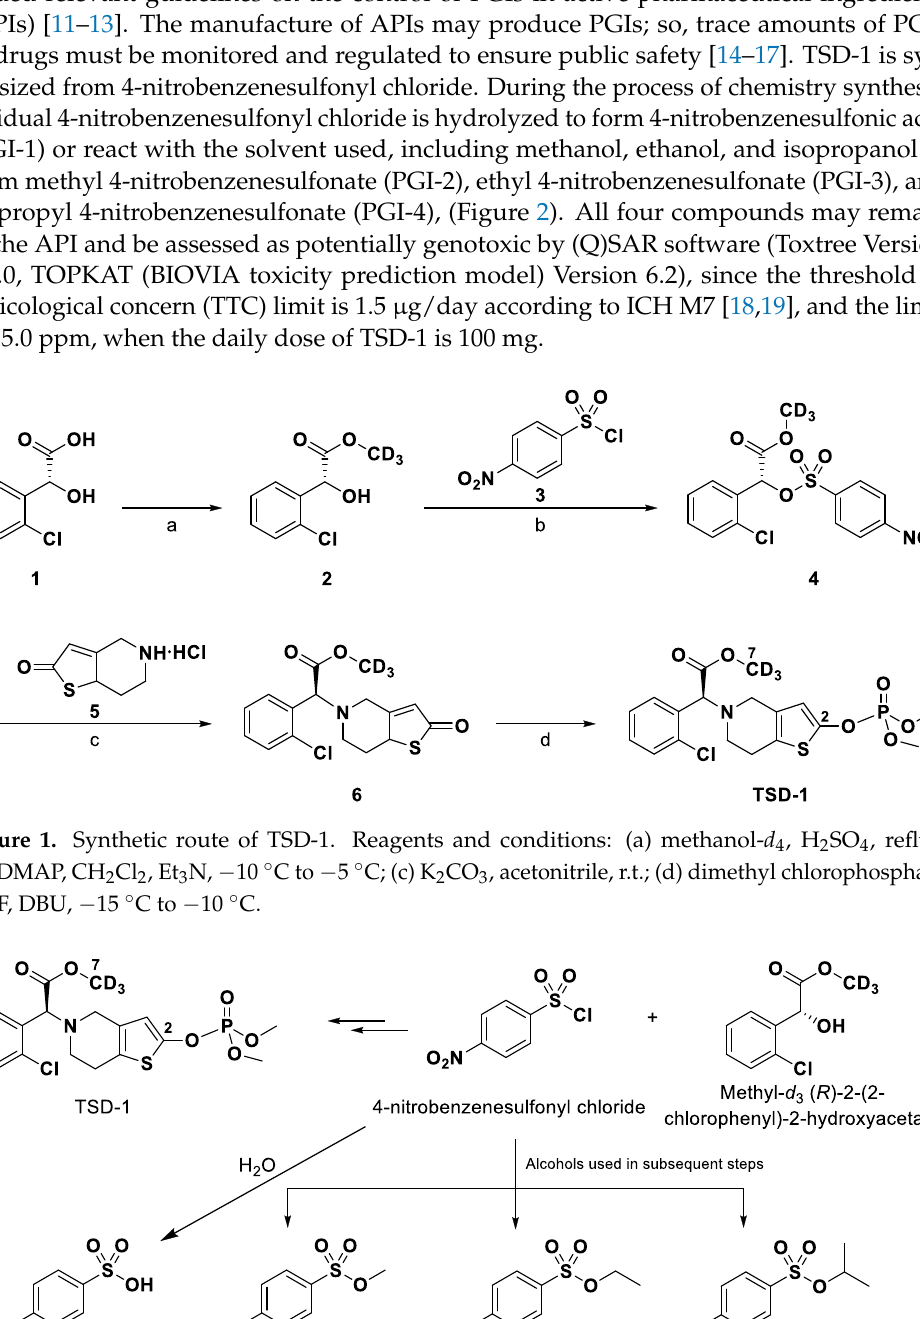
Figure 2. Formation of genotoxic impurities PGI-1, PGI-2, PGI-3, and PGI-4 during the synthesis of TSD-1.